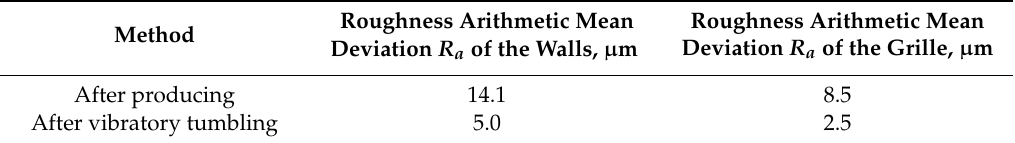
Figure 7. Topology and microroughness of the 12Kh18N9T (DIN 1.4541) steel sample top surfaces before and after vibratory tumbling: ( a ) SEM image before finishing, 1.00k × ; ( b ) SEM image after finishing, 1.00k × ; ( c ) profile before finishing; ( d ) profile after finishing. Table 5. The 12Kh18N9T (DIN 1.4541) steel surface roughness before and after vibratory tumbling.